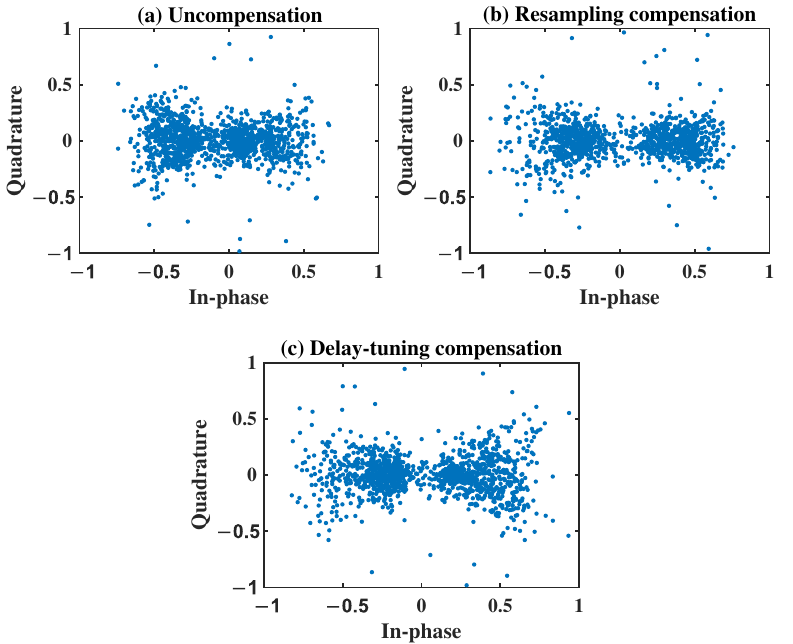
Figure 13. The uncoded constellation under different communication schemes of the sea